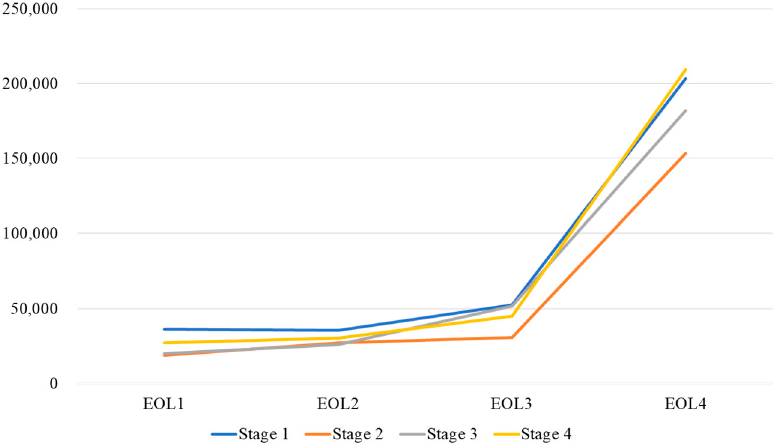
Figure 1. Medical cost in every quarter in the year before death in COPD patients using the 2007 COPD staging edition.